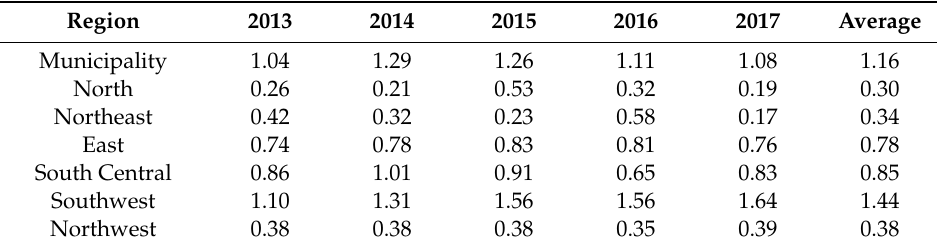
Table 9. Regional di ff erence of water resources’ use e ffi ciency in China.